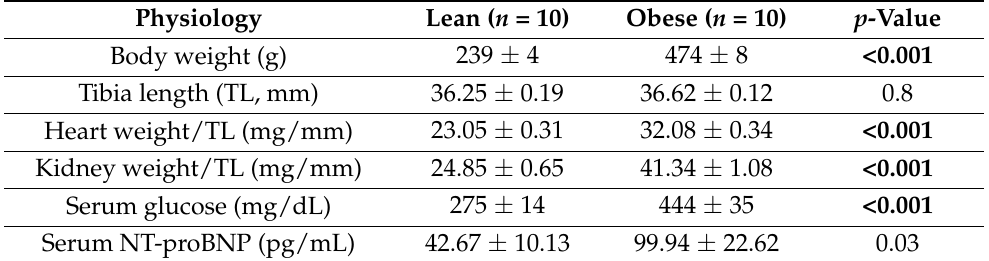
Table 1. Baseline characterization of the 20-week-old lean and obese